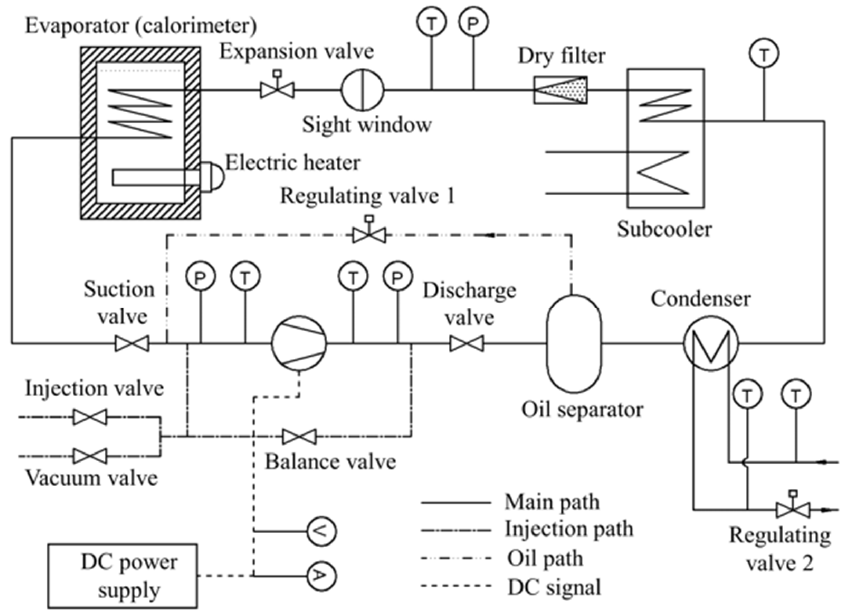
Figure 5. Schematic diagram of the calorimetric test system. Table 4. Measured accuracy and range of the main test device.